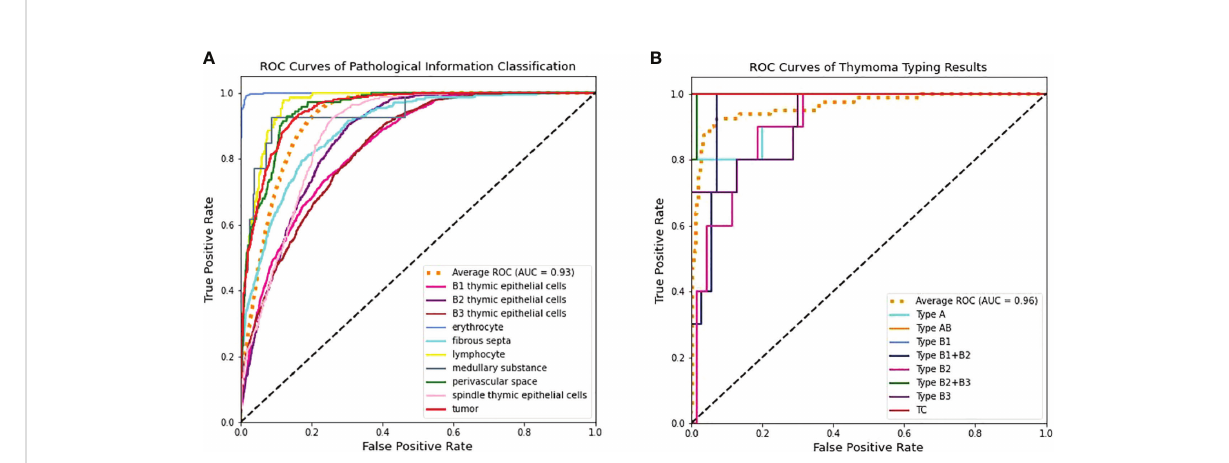
FIGURE 7 The ROC curve and AUC on the THW dataset. (A) Pathological information classi fi cation and (B) thymoma typing.